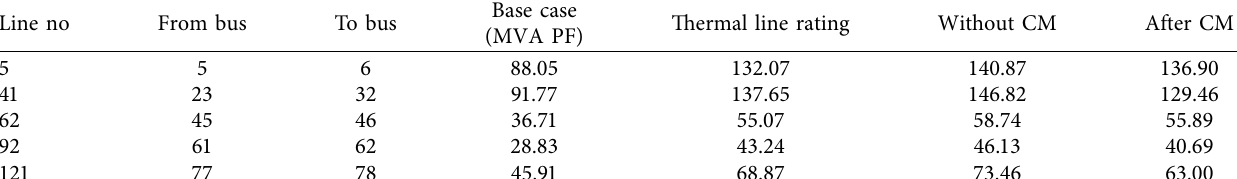
Table 16: Power fows of case 1 for IEEE 118-bus system.